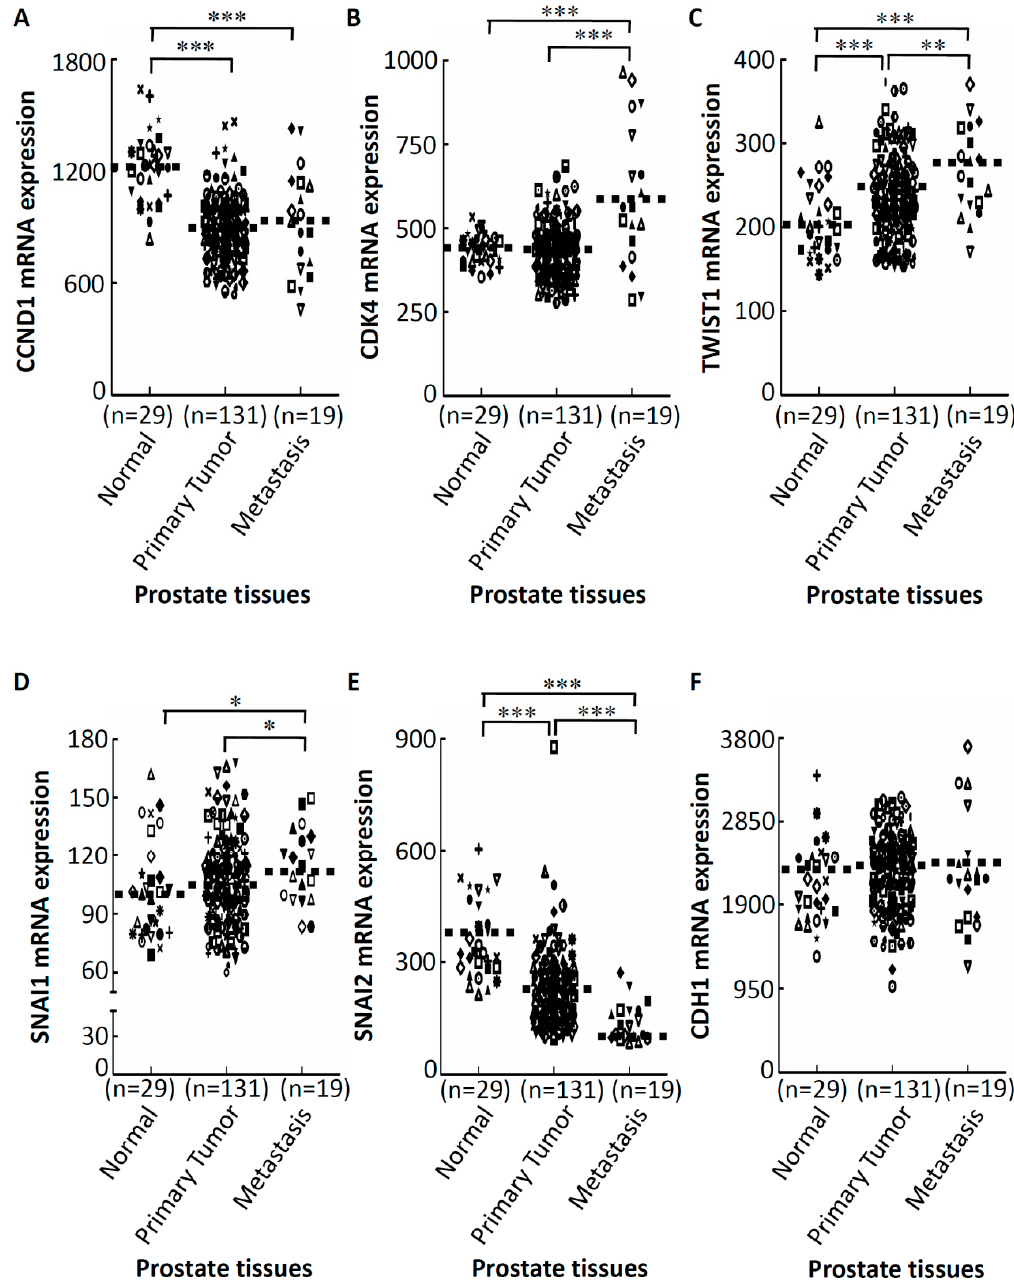
Figure 3. Aberrant expressions of GA-modulated cell cycle-related genes and EMT-related genes expression of prostate cancer patients. Relative expression levels of CCND1 ( A ), CDK4 ( B ), TWIST1 ( C ), SNAI1 ( D ), SNAI2 ( E ), and CDH1 ( F ) in different clinical stages of prostate cancer tissues analyzed using the public Gene Expression Omnibus (GEO) database (GSE21032). ∗ p <0.05, ∗∗ p <0.01, ∗∗∗ p <0.001.